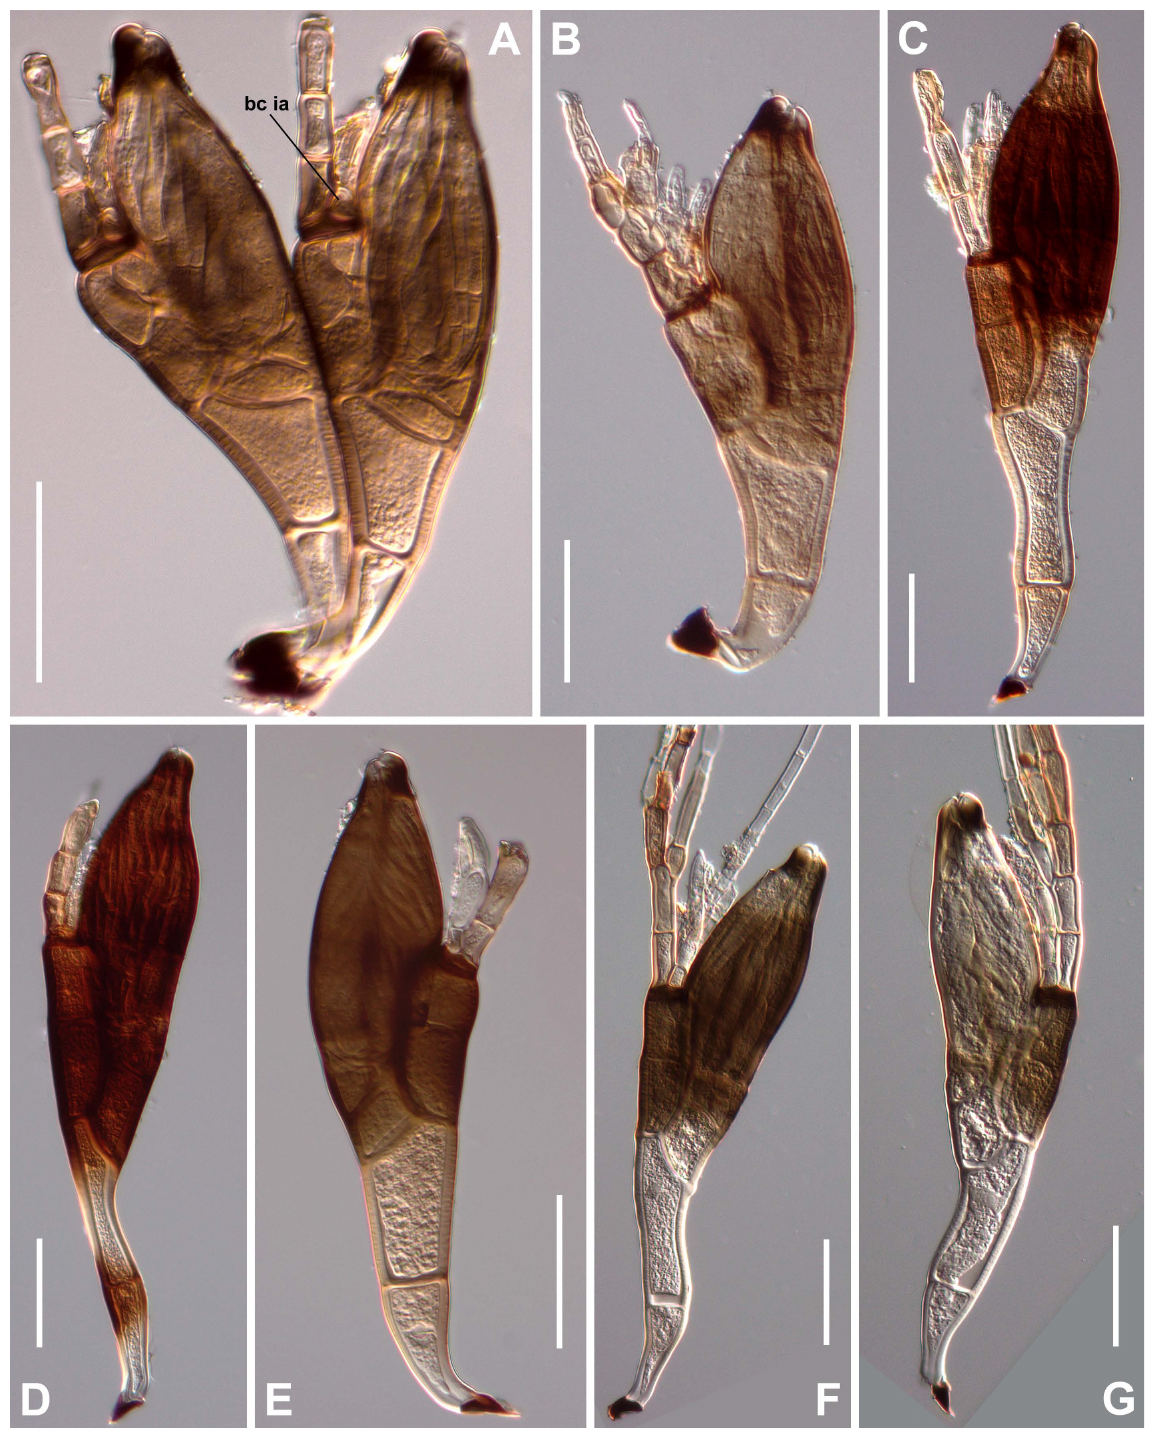
Fig. 45. Laboulbenia vulgaris Peyr. Mature thalli. In A the basal cell of the inner appendage has been labelled. A . From Trechus quadristriatus . B . From Epaphius secalis . C – D , F – G . From Bembidion mannerheimi . E . From Bembidion obtusum . Scale bars: 50 µm. Photographs from slides ZMUC C-F- 122615 (A), ZMUC C-F-123439 (B), ZMUC C-F-123392 (C), ZMUC C-F-123404 (D), ZMUC C-F- 123734 (E), ZMUC C-F-123861